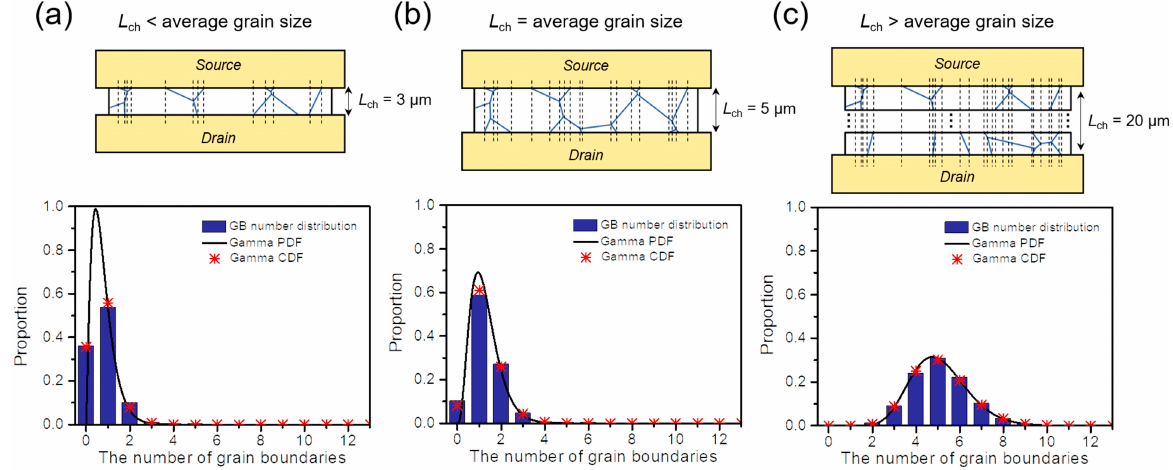
Figure 2. Histogram distributions of the proportion of the GB number within the channel region when the channel length is ( a ) less than the average grain size, ( b ) equal to the average grain size, and ( c ) greater than the average grain size. Each distribution was evaluated by counting the GB number within narrow width elements divided into 10 5 . The black dashed lines in ( a – c ) indicate the locations where the number of GBs changes. For all channel lengths, the envelope of the proportional distribution of the number of GBs follows the continuous probability density function of the gamma distribution (gamma PDF), and the discrete proportion distribution of the GB number can be estimated from the cumulative distribution function of the gamma distribution (gamma CDF) with an accuracy greater than 98%.